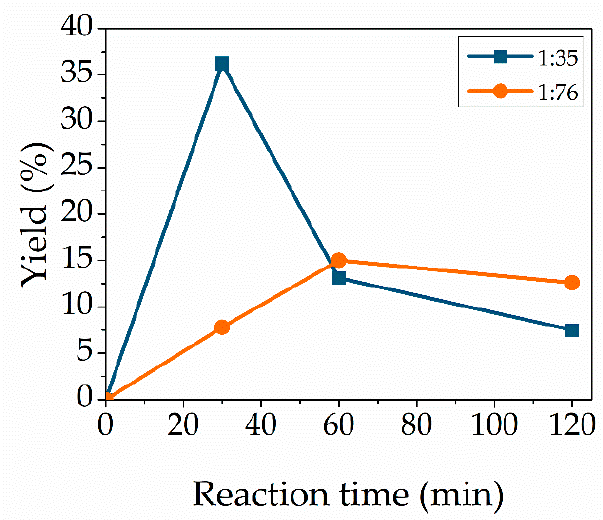
Figure 6. Effect of molar ratio. Reaction conditions: cytidine (100 mg, 0.414 mmol), Novozym 435 (12.7 wt%), 95 °C, vinyl methacrylate with a molar ratio of 1:35 (blue) or 1:76 (orange). Lines are included as a guide to the eye.